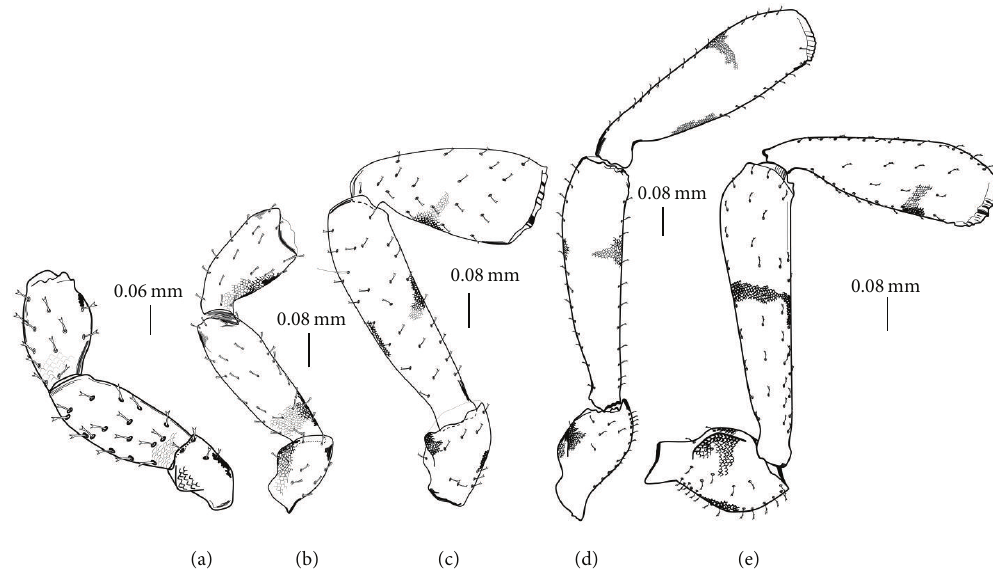
Figure 9: Pedipalps of Dactylochelifer gracilis : (a) protonymph, (b) deutonymph, (c) tritonymph, (d) male, and (e)